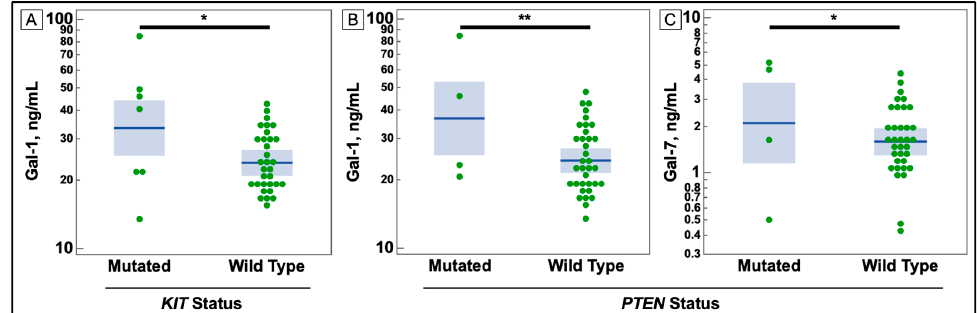
Figure 3. Comparison of Serum Galectin Levels of Breast Cancer Patients KIT Gene Mutation Status in Tumor Sample. ( A ) Serum levels of galectin-1, as determined by ELISA, were significantly higher in breast cancer patients with a mutation in the KIT gene. ( B ) Serum levels of galectin-3, as deter- mined by ELISA, were significantly higher in breast cancer patients with a mutation in the KIT gene. ( C ) Serum levels of galectin-8, as determined by ELISA, were significantly higher in breast cancer patients with a mutation in the KIT gene. ( D ) Serum levels of galectin-9, as determined by ELISA, were significantly higher in breast cancer patients with a mutation in the KIT gene. (* p -value ≤ 0.05).